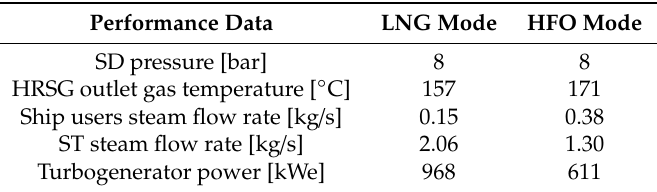
Table 2. WHR system performance at 75% of the engine load.